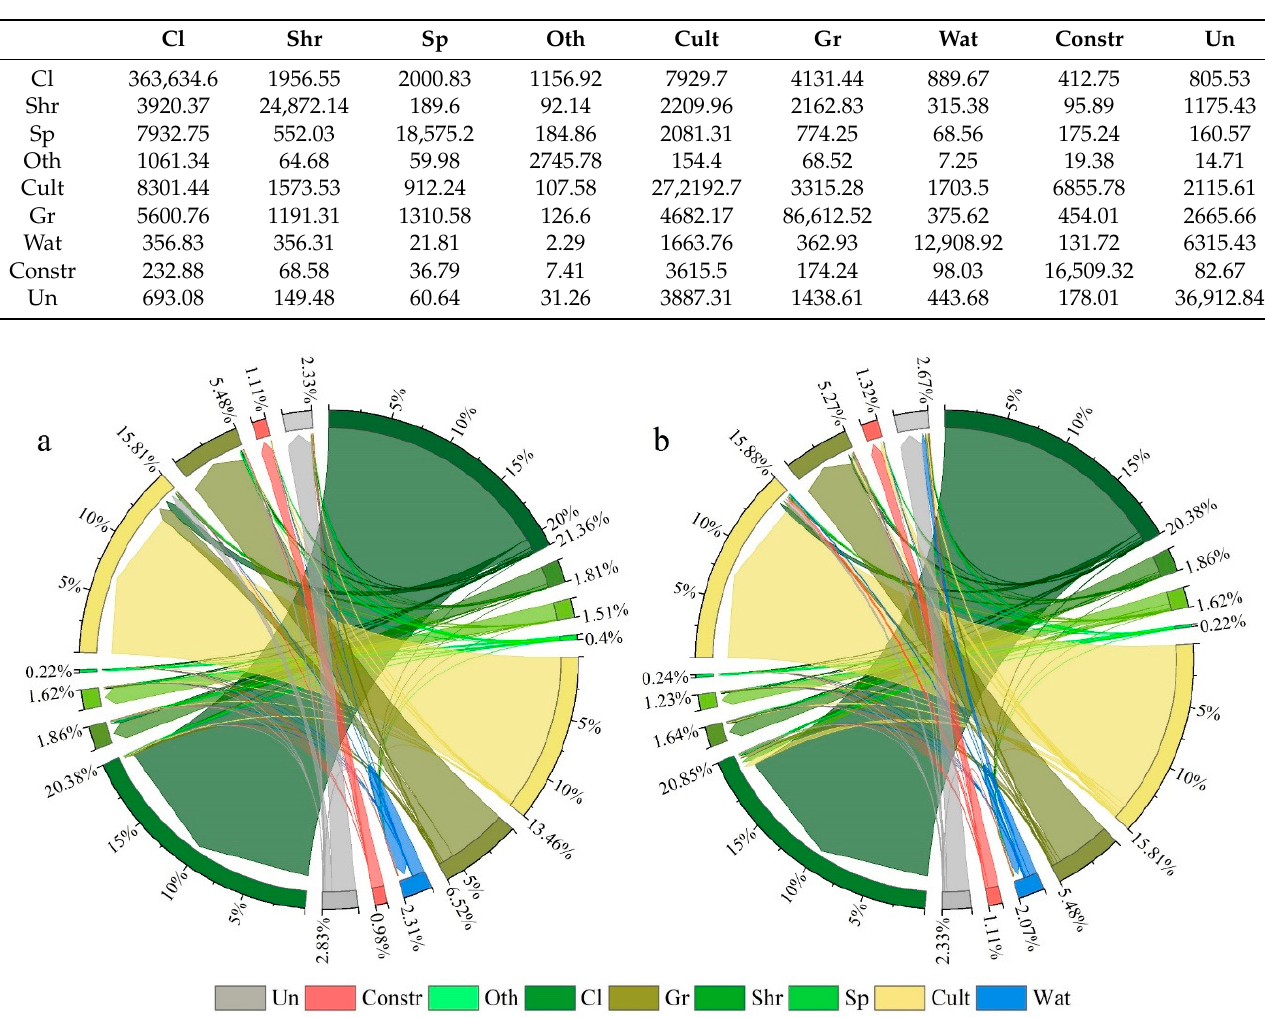
Table 7. Conversion of Land Types from 2000 to 2020 (km 2 ).